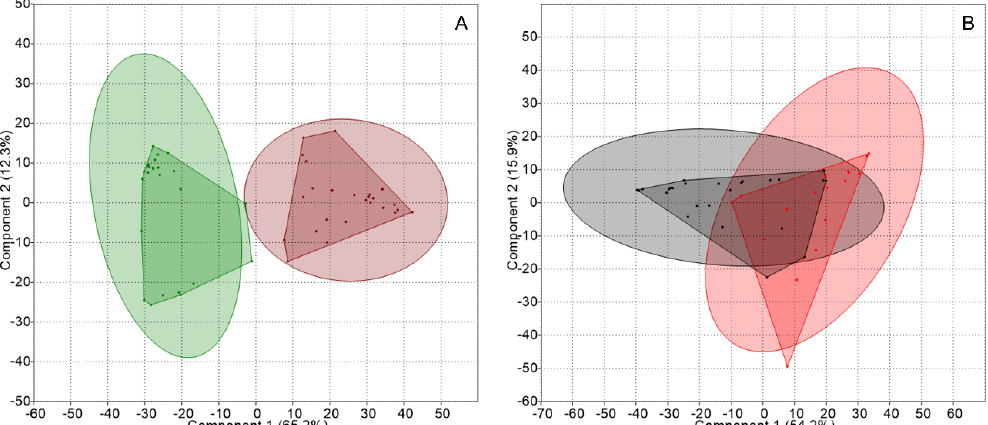
Figure 2. PCA of the genetic structure of the nitrogen-fixing guild associated with thalli and substrates: ( A ) Peltigera thalli (green) and Cladonia thalli (red), and ( B ) Peltigera substrates (brown) and Cladonia substrates (gray). Concentration ellipses ( ovals surrounding the convex hulls ) estimate the region where 95% of population points are expected to fall . Finally, the Shannon diversity index (H’) values of the nitrogen-fixing bacteria from thalli and substrates of both types of lichens were compared using an analysis of variance (ANOVA-Tukey, p ≤ 0.05). A higher diversity of TRFs was found for the nitrogen-fixing bacteria associated with the Cladonia thalli than the Peltigera thalli, whilst the diversity of nitrogen-fixers from Peltigera substrates and Cladonia substrates was similar, as shown in Figure 3.